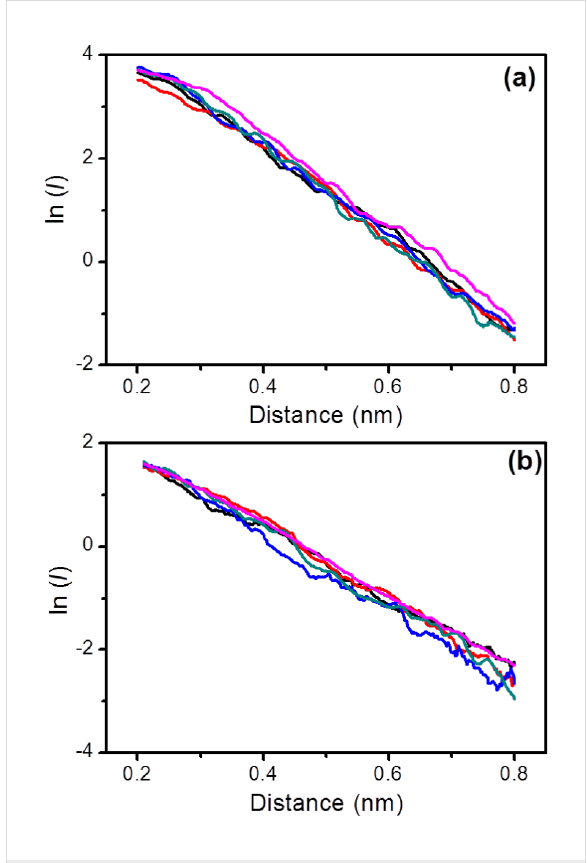
Figure 7: (a) ln I vs s plots used for the calibration of tip–substrate dis- tance (a) for 1 in LB films (for recording dlnI/ds for inside the LB film the tip was retracted from deep in the LB film to the length of the verti- cally extended molecule, with dlnI/ds remaining relatively low over this range); and (b) for 1 single